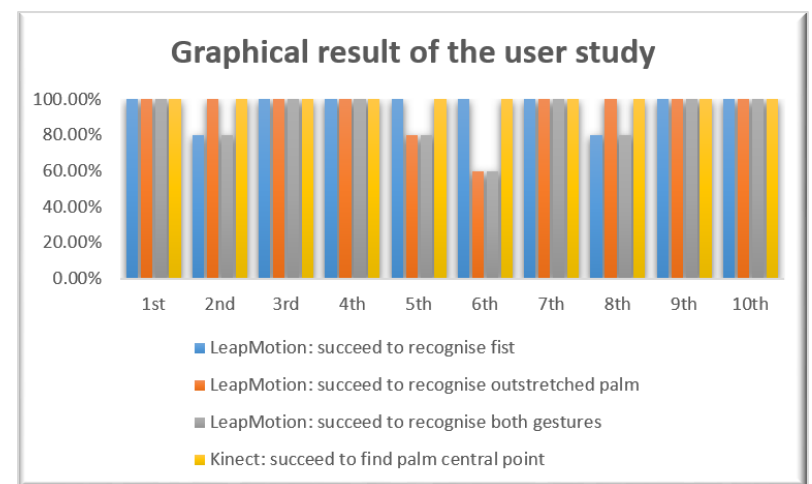
Figure 9. The bar chart graph of the blinded test